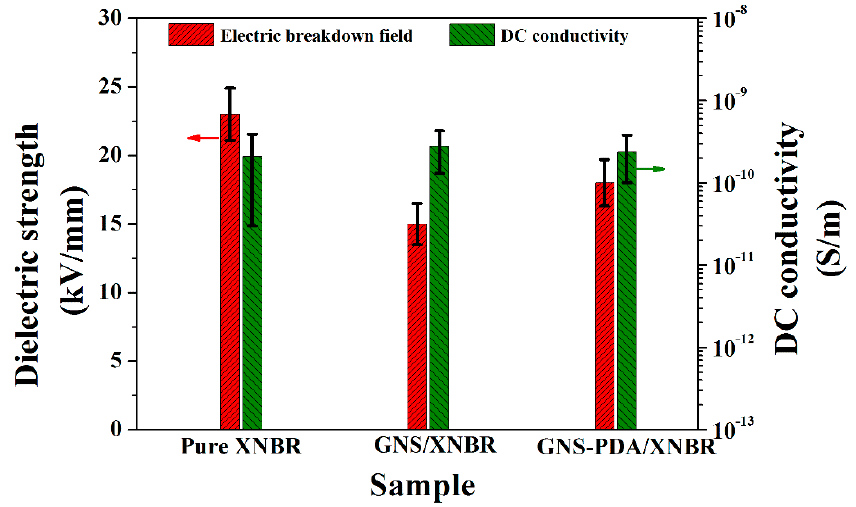
Figure 8. Dielectric strength and DC conductivity for pure XNBR, GNS/XNBR composite, and GNS-PDA/XNBR